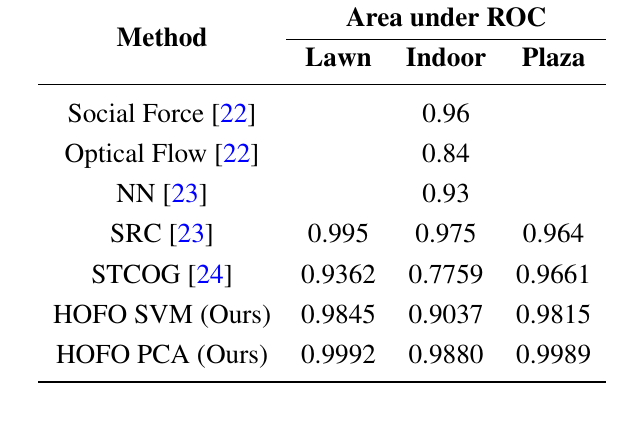
Table 1. The comparison of our proposed method with the state-of-the-art methods for global abnormal event detection in the UMN dataset. TPR, true positive rate; FPR, false positive rate. NN, nearest neighbor. SRC, sparse reconstruction cost. STCOG, spatial-temporal co-occurrence Gaussian mixture models. Method